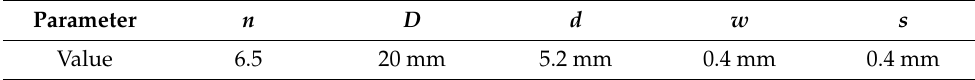
Figure 1. Investigated planar inductive sensor topologies: ( a ) spiral, ( b ) non-spiral, and ( c ) mean- der. Table 1. Geometrical dimensions of the PCB-based manufactured inductors. Table 1. Geometrical dimensions of the PCB-based manufactured inductors.